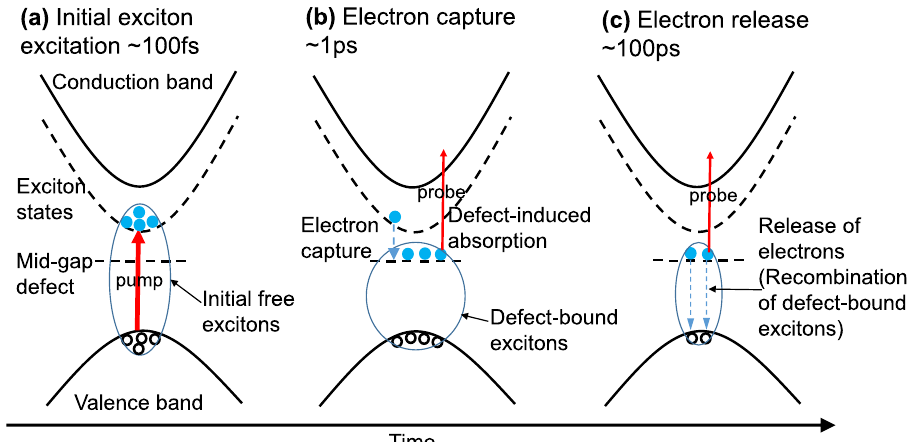
Fig. 2 Schematic of the dynamics of mid-gap defects capturing and releasing photoexcited electrons in MoSe 2 . a Initial free exciton generation by the resonant pump laser pulse. b The excited electrons being captured by the mid-gap defects, after which the transitions from defect states to high energy states in the conduction band become available and increase the absorption of the probe. c The trapped electrons being released by the mid-gap defects and back to the valence